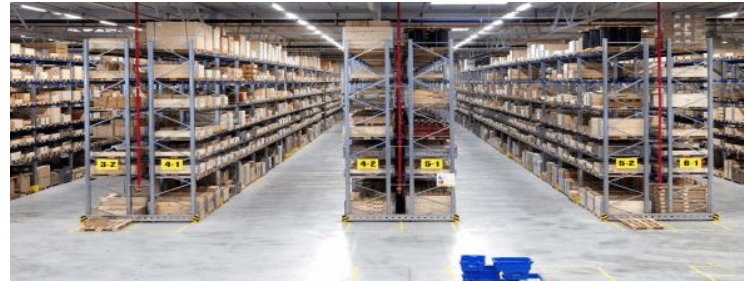
Figure 1. Warehouse of the